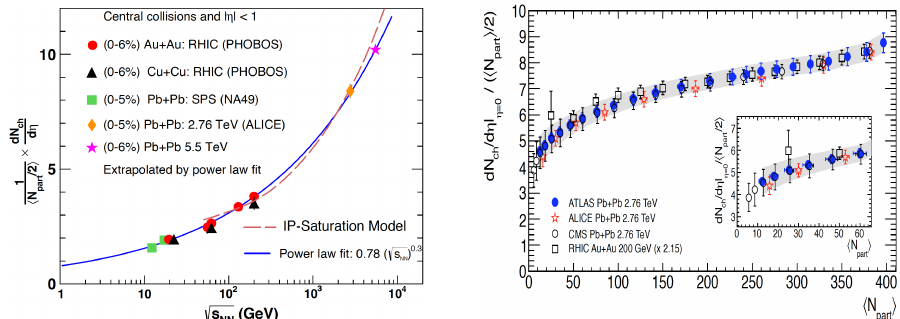
Figure 17. Left : The charged particle rapidity density per participaiting pair, dN ch / d η /(0.5 N part ), in central Au + Au, Cu + Cu, and Pb + Pb collisions from SPS to LHC energies. The star denotes an extrapolation to Pb + Pb collisions at 5.5 TeV. The IP -saturation model calculation [312] is illustrated by a dashed curve. Adapted from Ref. [30]; Right : dN ch / d η /(0.5 N part ) vs. Au + Au collisions at the LHC and RHIC, respectively. The RHIC data are multiplied by 2.15. The inset (cid:10) (cid:11) N part shows the < 60 region in more detail. Reproduced from Ref.